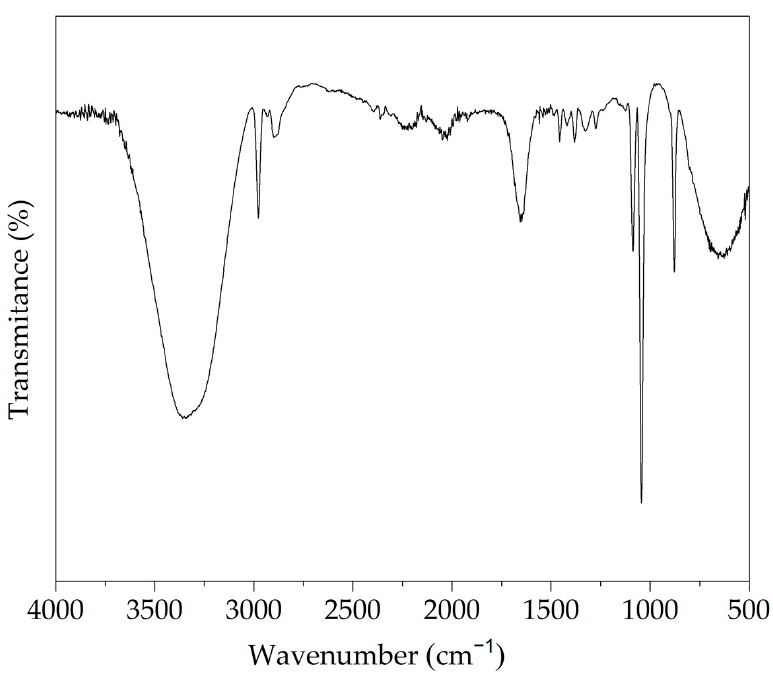
Figure 7. FTIR spectrum of the extract from Welsh onion leaves obtained at the optimal UAE conditions: extraction temperature of 60 °C, time of 10 min, and ethanol concentration of 70% v/v .